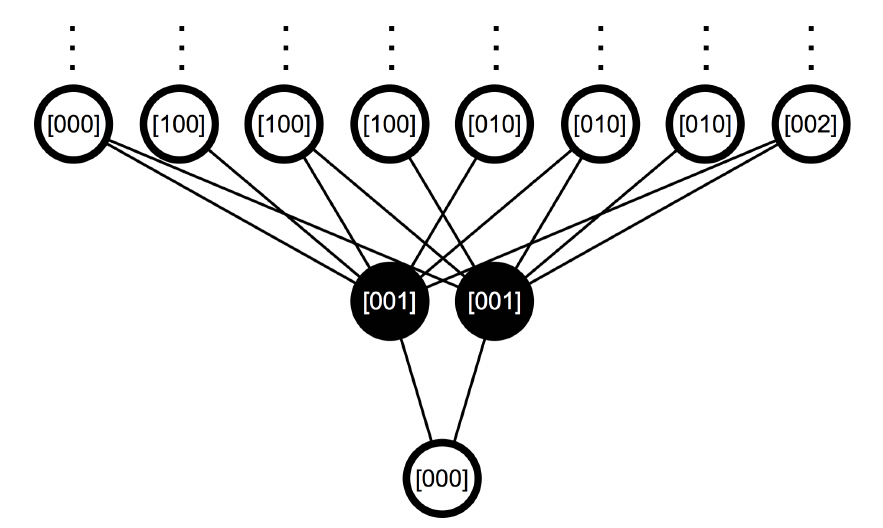
Figure 7 . Adynkra Diagram for 7D minimal scalar superfield.